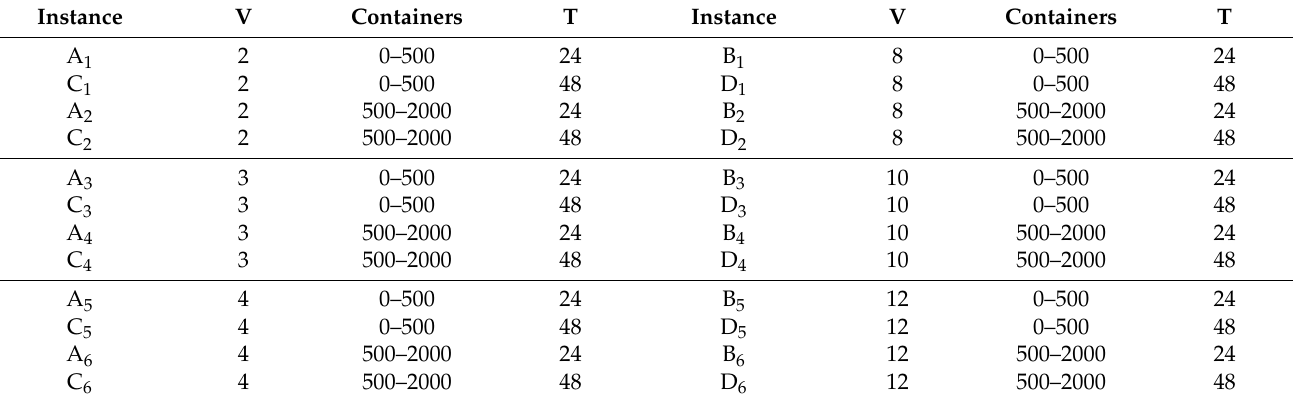
Table 2. Description of instances